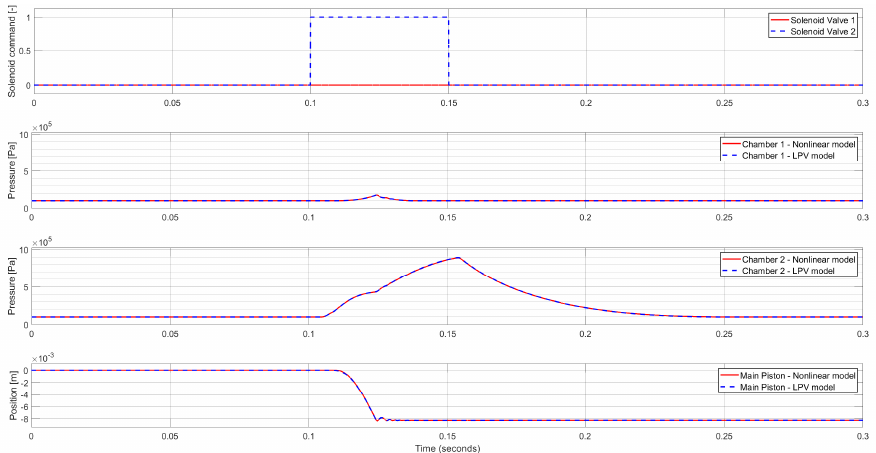
Figure 2. LPV model validation—Neutral to Low test